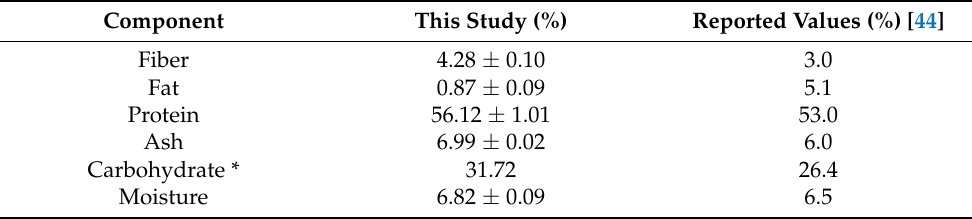
Table 3. Physicochemical characterization of NaCl electrolysis by-product solutions. Sanitizer Electric Current Concentration Intensity (A) *